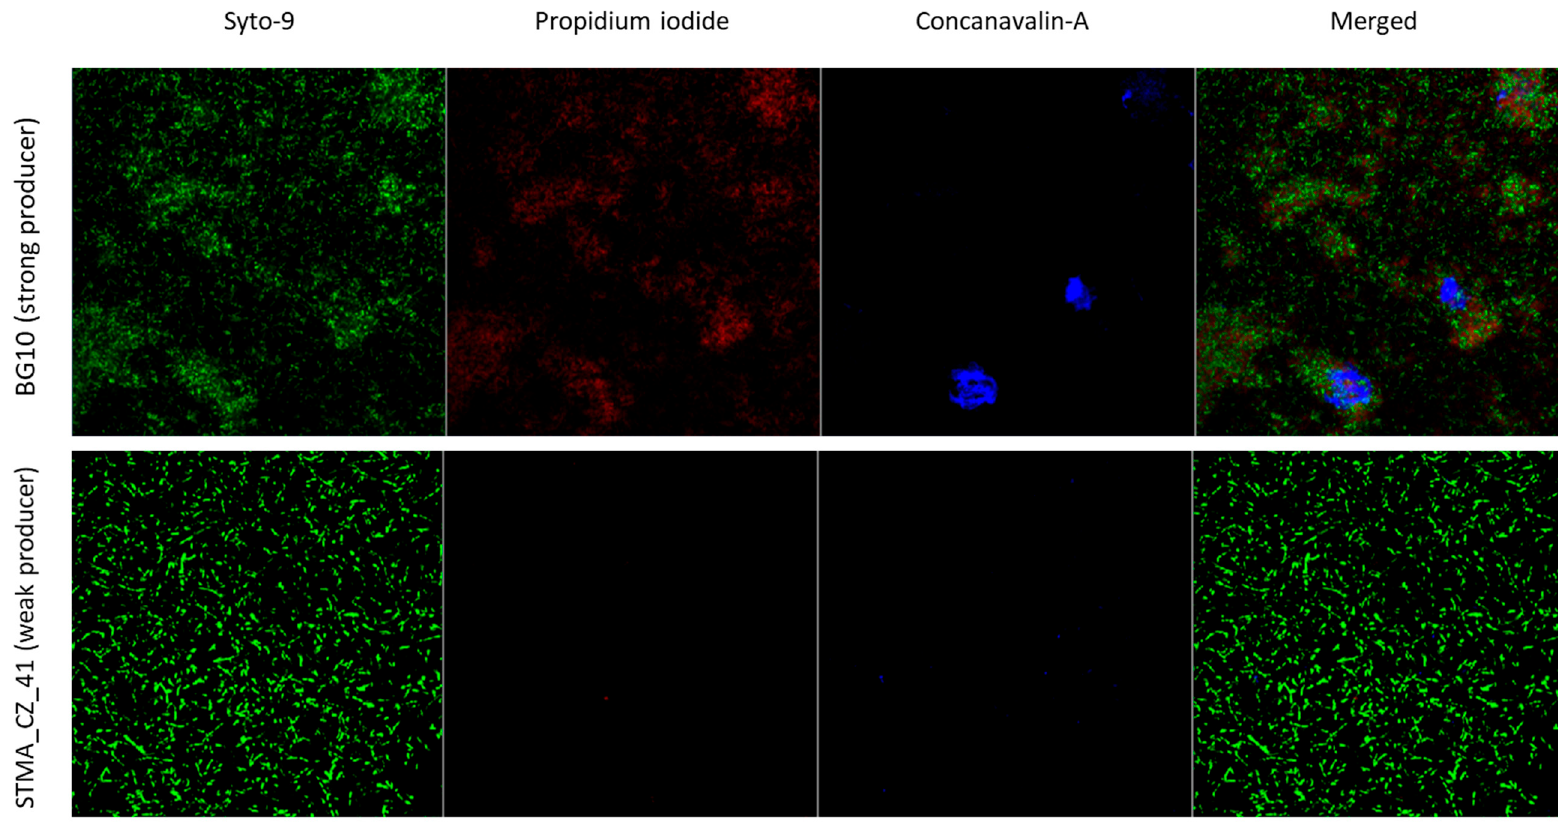
Figure 6. Ultrastructure analysis of S. maltophilia biofilm: confocal laser scanning microscopy. The biofilm was allowed to form in a μ -Dish for 24 h at 37 °C by S. maltophilia BG10 and STMA_CZ_41 strains, respectively representative of “strong” and “weak” biofilm producer classes. Biofilm sample was then stained using BacLight Live/Dead kit: Syto-9 tags live cells (green fluorescence); propidium iodide tags dead cells (red fluorescence); and Concanavalin-A tags extracellular polymeric substance (blue fluorescence). Merged: co-localization of Syto-9, propidium iodide and Concanavalin-A. Magnification: 1000×.